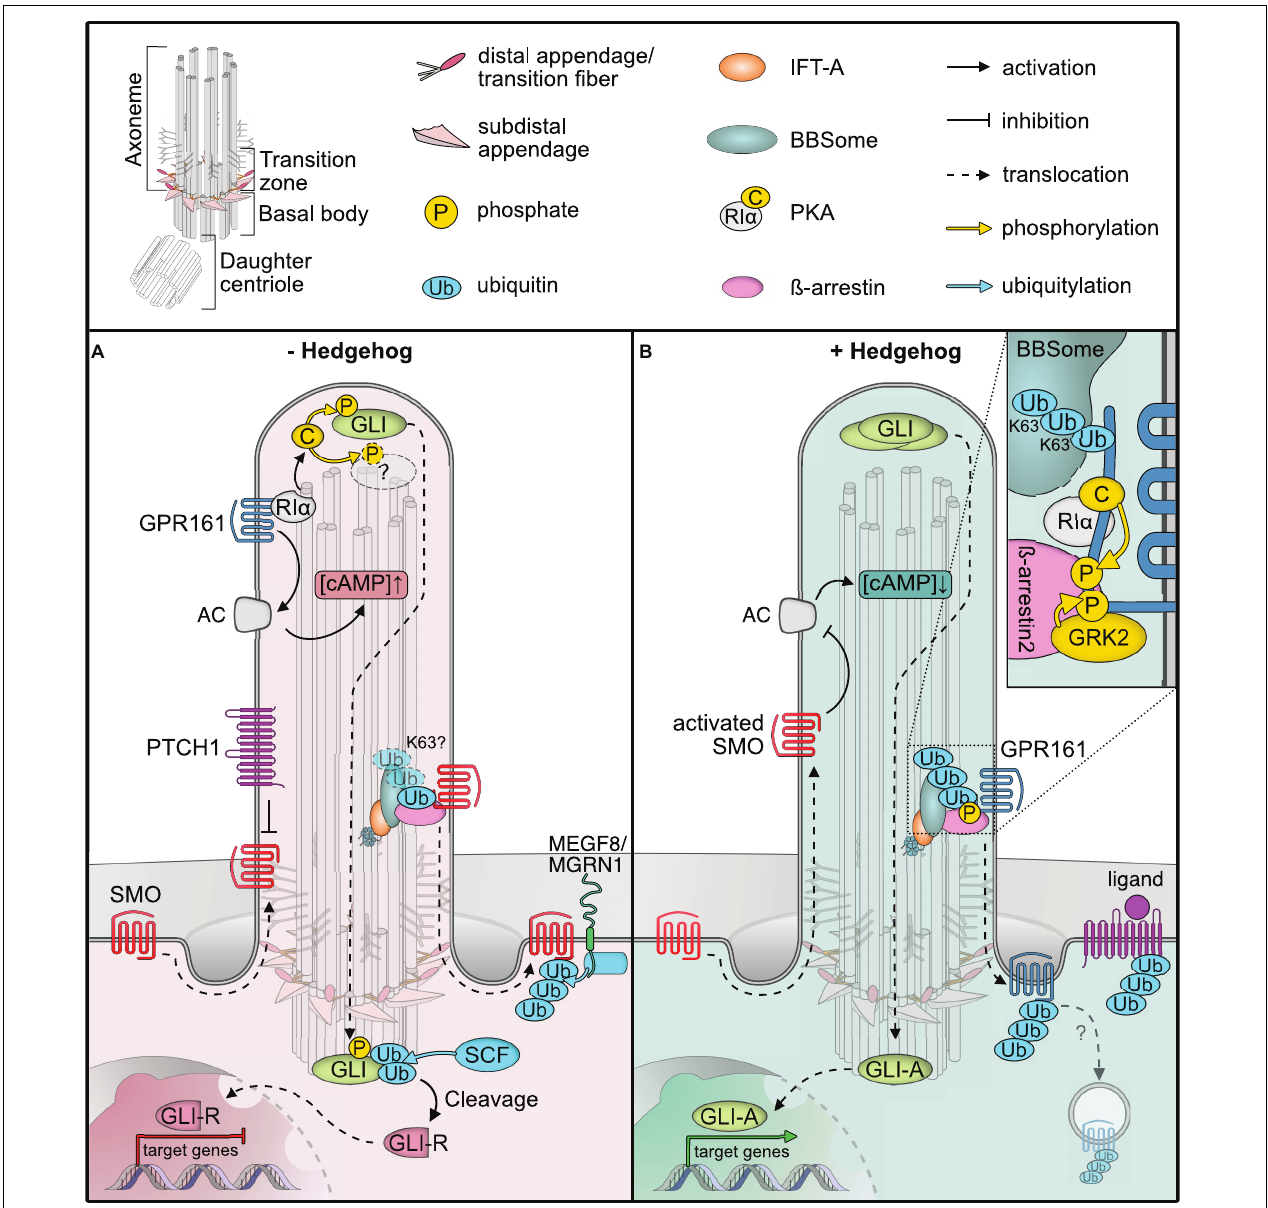
FIGURE 1 | Post-translational modifications (PTMs) regulating Hedgehog signaling. (A) In unstimulated cells, the GPCR SMO constantly surveys the cilium without accumulation, due to constant removal in a ubiquitin (Ub) and BBSome-dependent manner. The Hedgehog receptor PTCH1 suppresses SMO, and the constitutively active GPCR GPR161 is retained in cilia. GPR161 stimulates adenylyl cyclases (AC) to generate cAMP. High cAMP is sensed by the regulatory PKA subunit I α (RI α ), which releases the PKA catalytic subunit (C) to phosphorylate target proteins, such as GLI transcription factors. GLI phosphorylation leads to ubiquitylation and proteolytic cleavage to GLI repressor forms (GLI-R) that repress target gene expression in the nucleus. The ubiquitin ligase MEGF is recruited to the plasma membrane by MGRN1 where it ubiquitinylates SMO for subsequent degradation. (B) In the presence of Hedgehog ligands, PTCH1 exits the primary cilium, presumably in a Ub-dependent fashion, leading to SMO activation and accumulation. GPR161 in turn is phosphorylated by GRK2 (and PKA). GPR161 phosphorylation is sensed by β -arrestin2, which leads to ubiquitylation and BBSome-mediated removal of GPR161 together with PKA from the primary cilium. Together with a drop in cAMP levels, GLIs are no longer phosphorylated and full-length GLIs activate target genes in the nucleus. After removal from cilia, the mechanism by which GPR161 is internalized remains unclear.